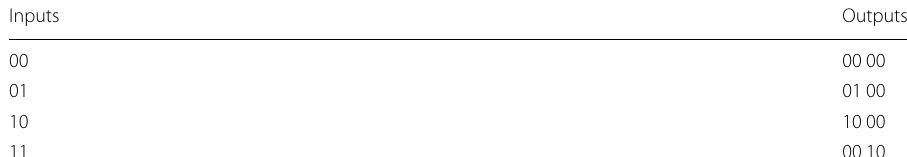
Table 1 Inputs/outputs of the shaping code (2,4) Inputs Outputs